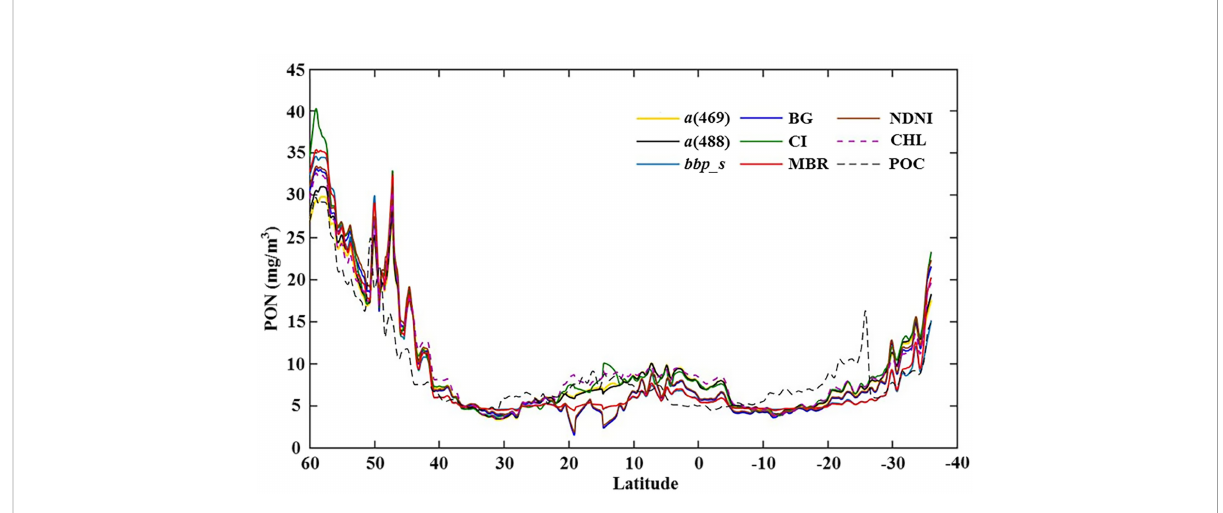
FIGURE 9 PON associated with an extracted transect through the Atlantic Ocean at 30° W for each